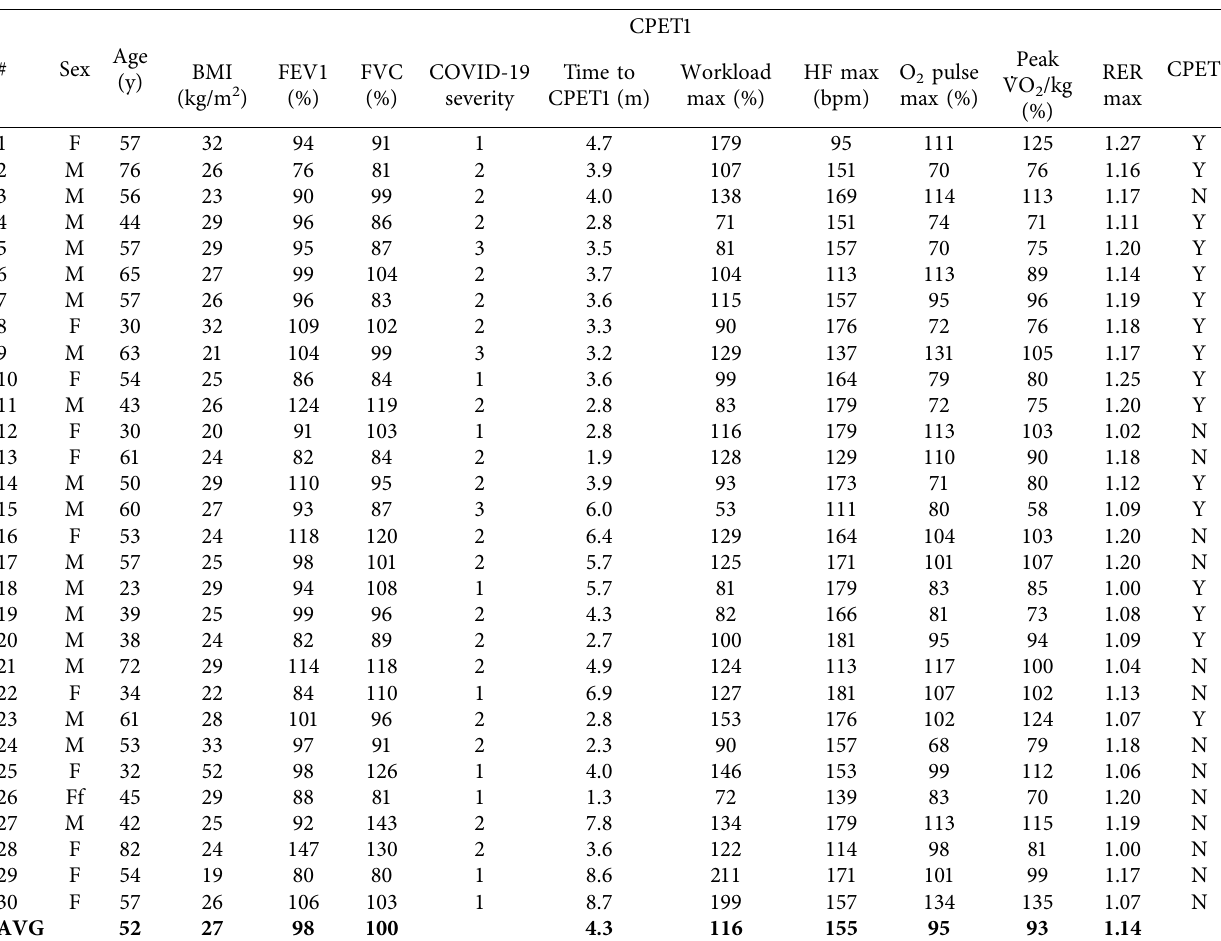
Table 1: Cohort characteristics.